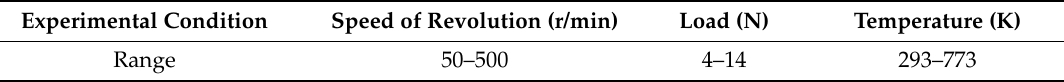
Table 4. Range of experimental